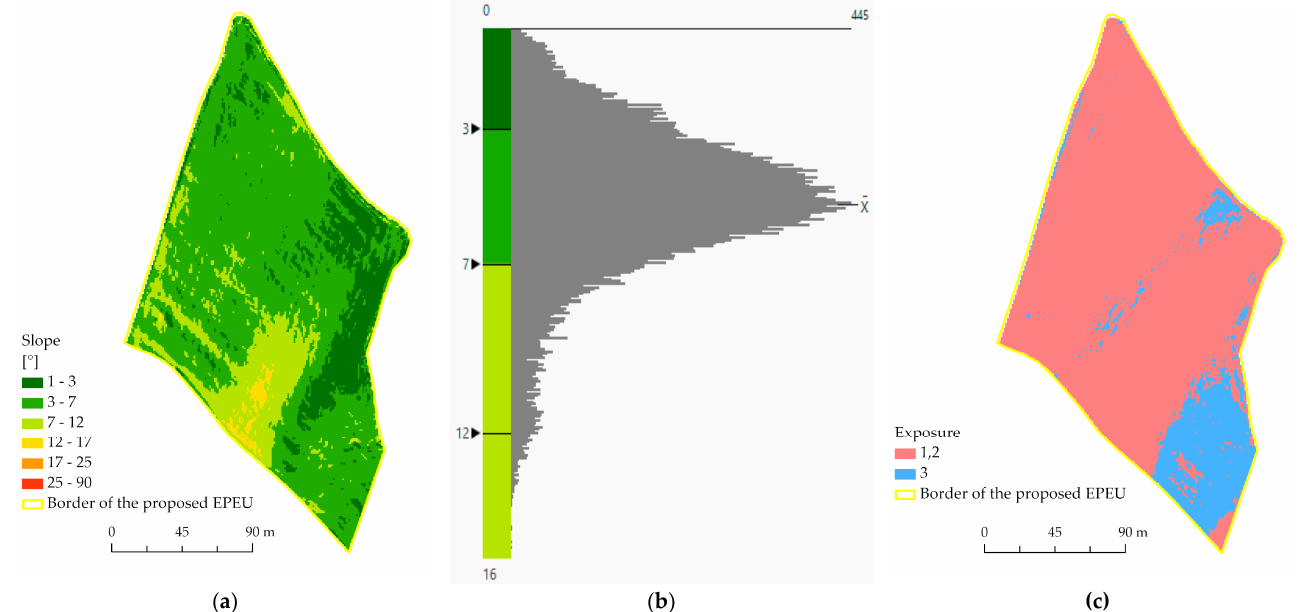
Figure 16. Verification of the EPEU code of the proposed area ( a ) slope analysis; ( b ) histogram from the slope analysis; ( c ) exposure analysis.